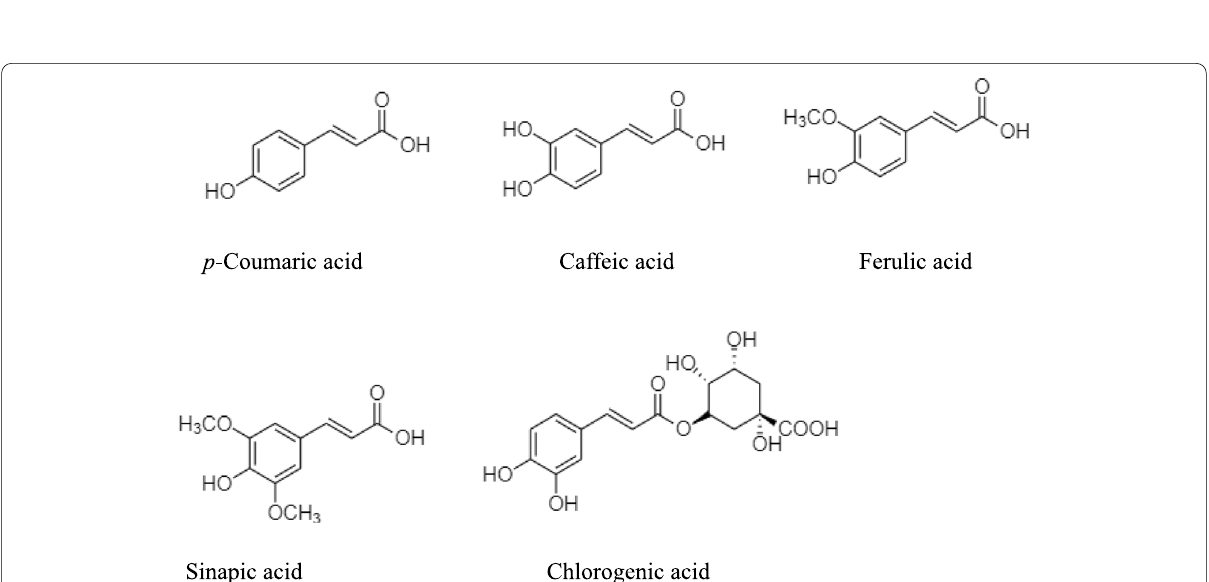
Fig. 3 Chemical structures of hydroxycinnamic acid